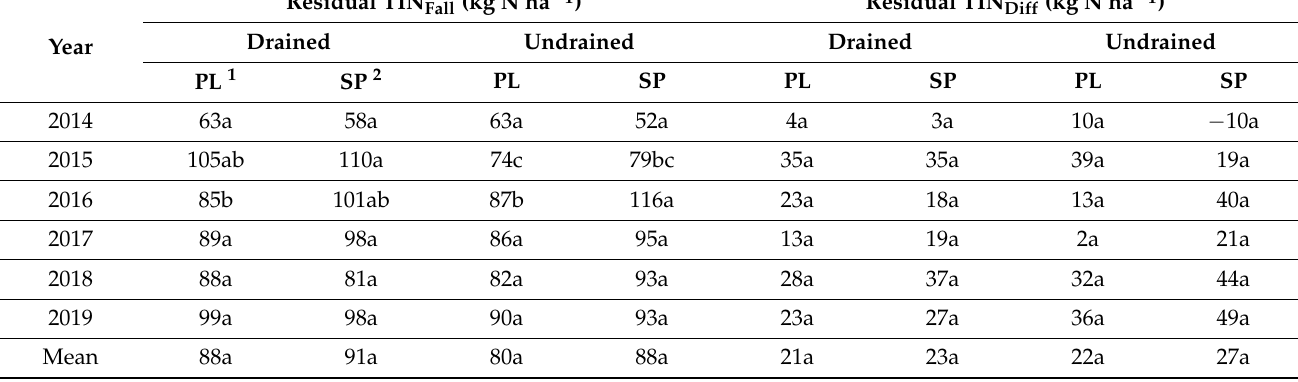
Table 4. Residual total inorganic nitrogen (TIN (NO 3 − -N plus NH 4+ -N)) measured from 0 to 90 cm soil depth in the fall (residual TIN Fall ) and difference between residual TIN between fall and next spring (residual TIN Diff ) as related to year, drainage condition, and fertilizer application timing. Means followed by the same letter are not different ( p < 0.1) within year and sampling time.